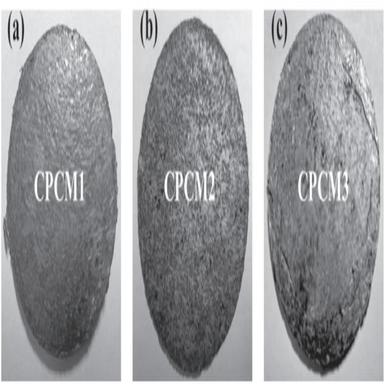
Leakage tests of CPCMs: (a) CPCM1; (b) CPCM2; (c) CPCM3.